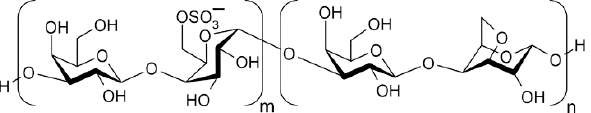
Figure 1. Idealized structure of porphyran, depicting the main repeating